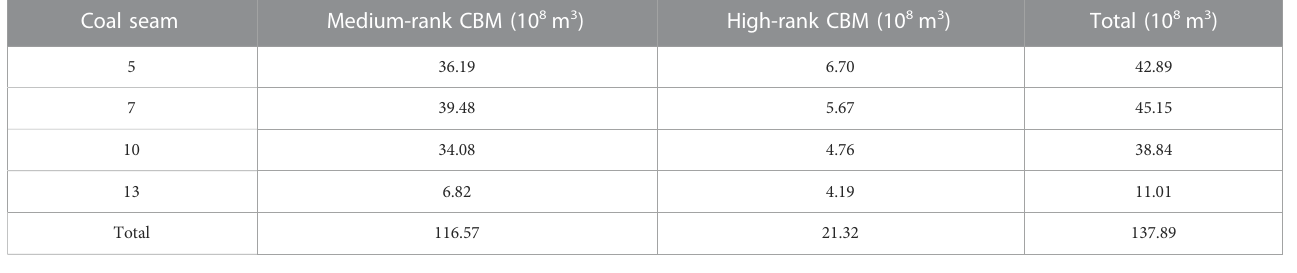
TABLE 5 Overview of CBM resources.